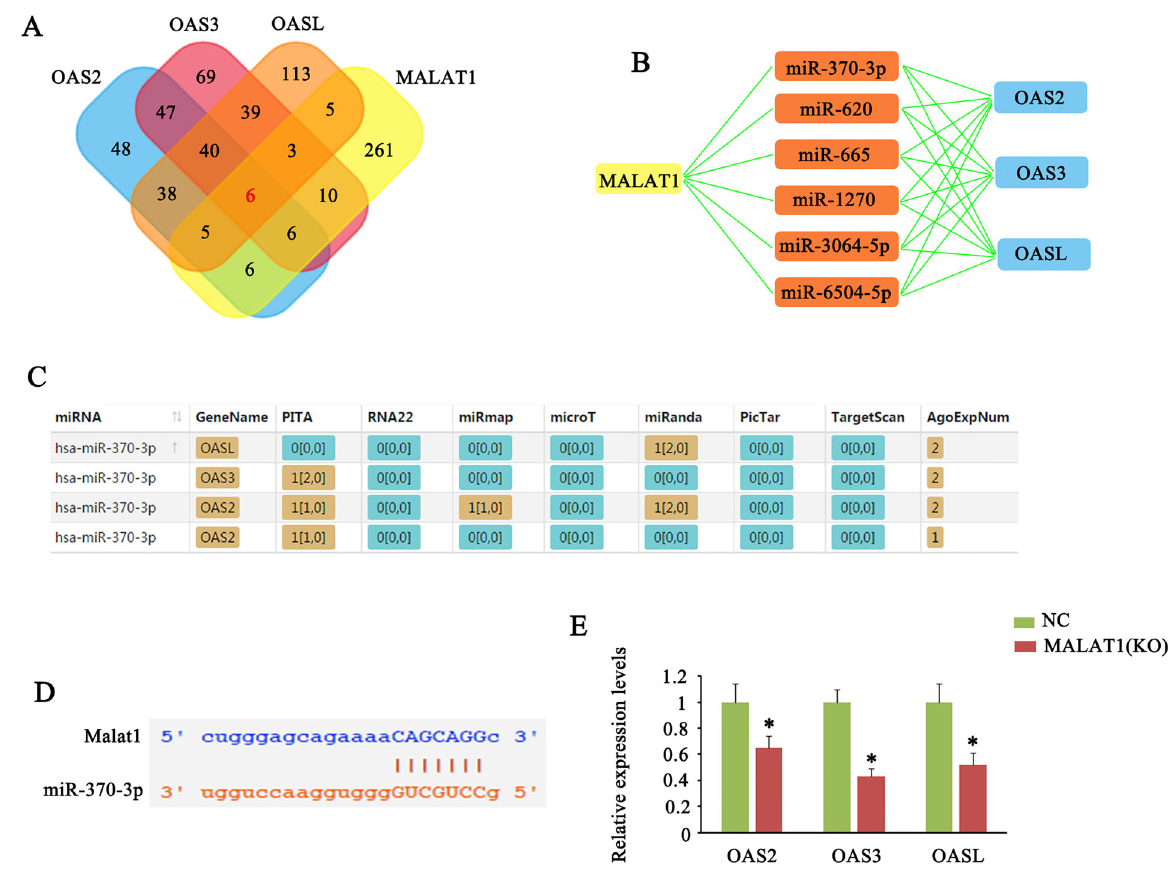
Figure 3. MALAT1 had potential effects on OAS2, OAS3, and OASL expression by interacting with miRNAs. A , The Venn diagram shows that six miRNAs can target all OAS2, OAS3, OASL, and MALAT1. B , MALAT1 can function as a ceRNA of these six miRNAs to block their effects on OAS2, OAS3, and OASL mRNA. C, For example, miR-370-3p was predicted to target OAS2, OAS3, and OASL. D , At the same time, miR-370-3p could also bind to MALAT1. E , PCR analysis showed that OAS2, OAS3, and OASL expression was also decreased with the knockdown of MALAT1. Data are reported as means ± SD. *P o 0.05 vs NC (negative control) (Student ’ s t -test). KO: knocked